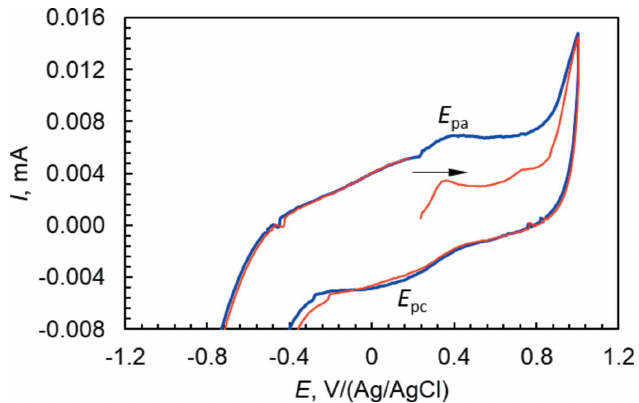
Figure 5 Cyclic voltammogram of (I), 0.1 m M in methanol mixed with 0.1 M acetate buffer (pH 4) and NaClO 4 (70:28:2) as supporting electrolyte at a glassy carbon electrode and Ag/AgCl as a reference electrode (scan rate: 100 mV s (cid:5) 1 ; T = 293 K).